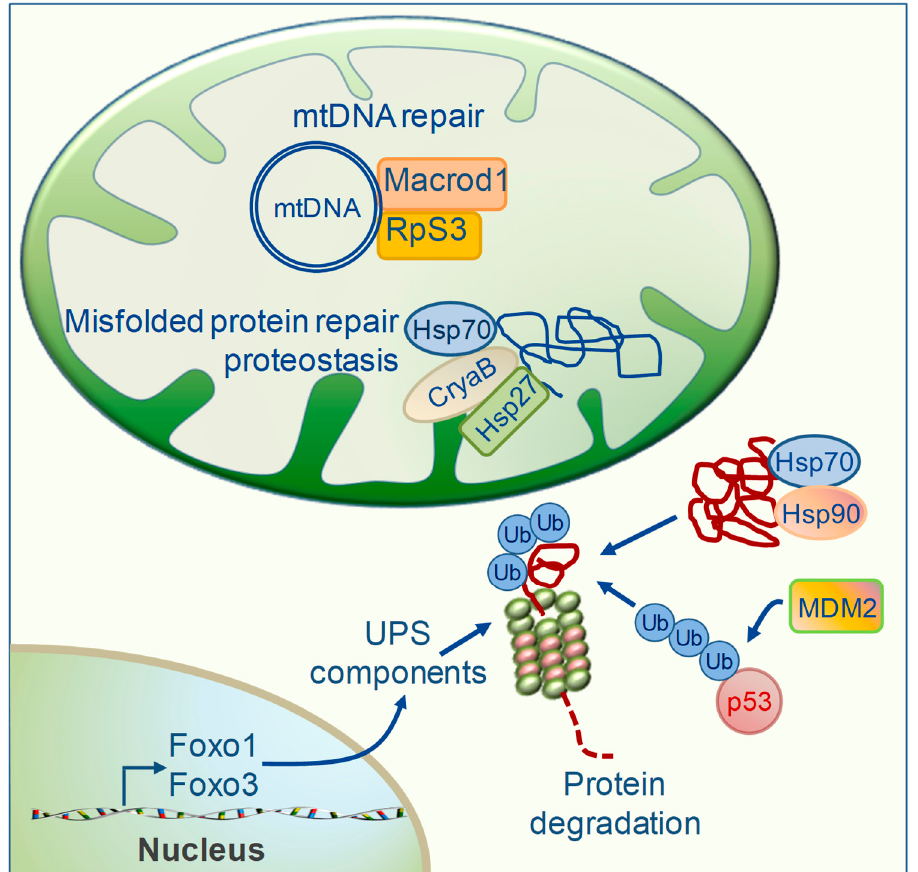
Figure 4. Effects of thyroid hormones (TH) on mitochondrial protein repair and proteostasis. Accumulation of damaged mitochondrial proteins and mutated mtDNA favors mitochondrial impairments and cell dysfunction. TH acts at multiple levels to avoid such dangerous effects. (1) T3 favors the repair of misfolded proteins or their chaperone-mediated degradation by enhancing the protein levels of small (HSP27, CryaB) and large (HSP 70 and 90) heat shock proteins; (2) T3 and T4 up-regulate Foxo1 and Foxo3, transcription factors that orchestrate the expression of components of the ubiquitin protesome system (UPS) for protein degradation; (3) T3 may favor the ubiquitination of p53 under cardiac stress conditions via the MDM2 pathway; (4) T3 favors the mitochondrial accumulation of DNA repair systems such as Macrod1 and Rps3. (CryaB: α -crystallin B; HSP: heat shock protein; Foxo1 / 3: forkhead box O 1 / 3; Macrod1: Mono-ADP Ribosylhydrolase; Mdm2: mouse double minute 2 homolog; mtDNA: mitochondrial DNA; RpS3: 40s ribosomal protein S3; ub: ubiquitin).